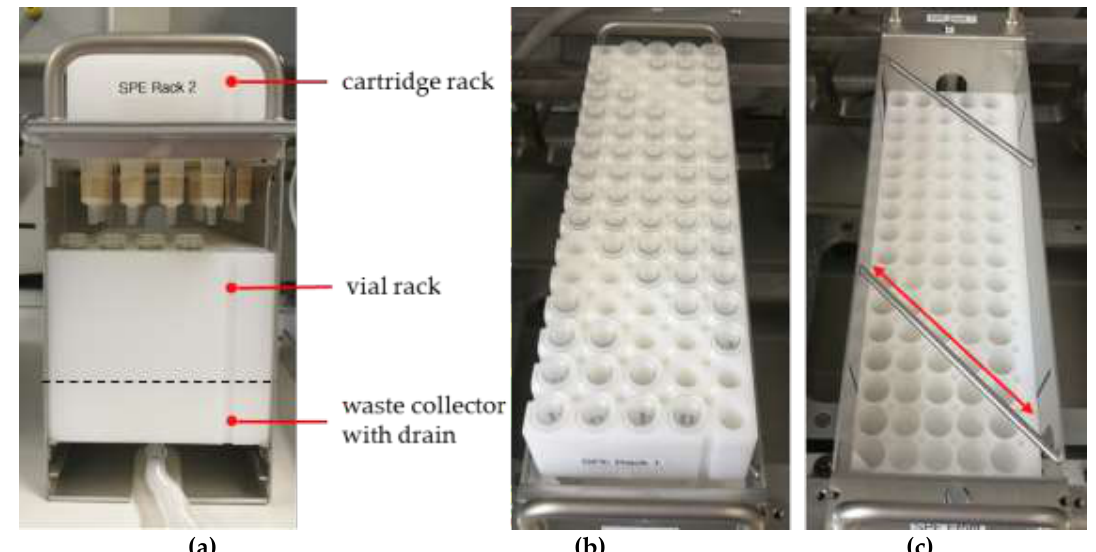
Figure 7. Solid phase extraction (SPE) rack: ( a ) front view (rack removed from the chem station) holding cartridges and vials; ( b ) top view, cartridge rack, implemented into the chem station; ( c ) top view, vial rack, implemented into the chem station.